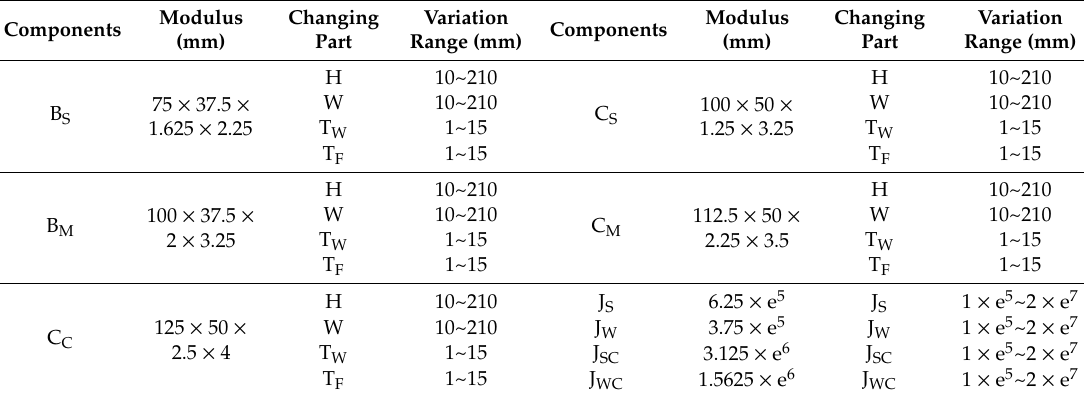
Table 5. Parameter variation range of sensitivity